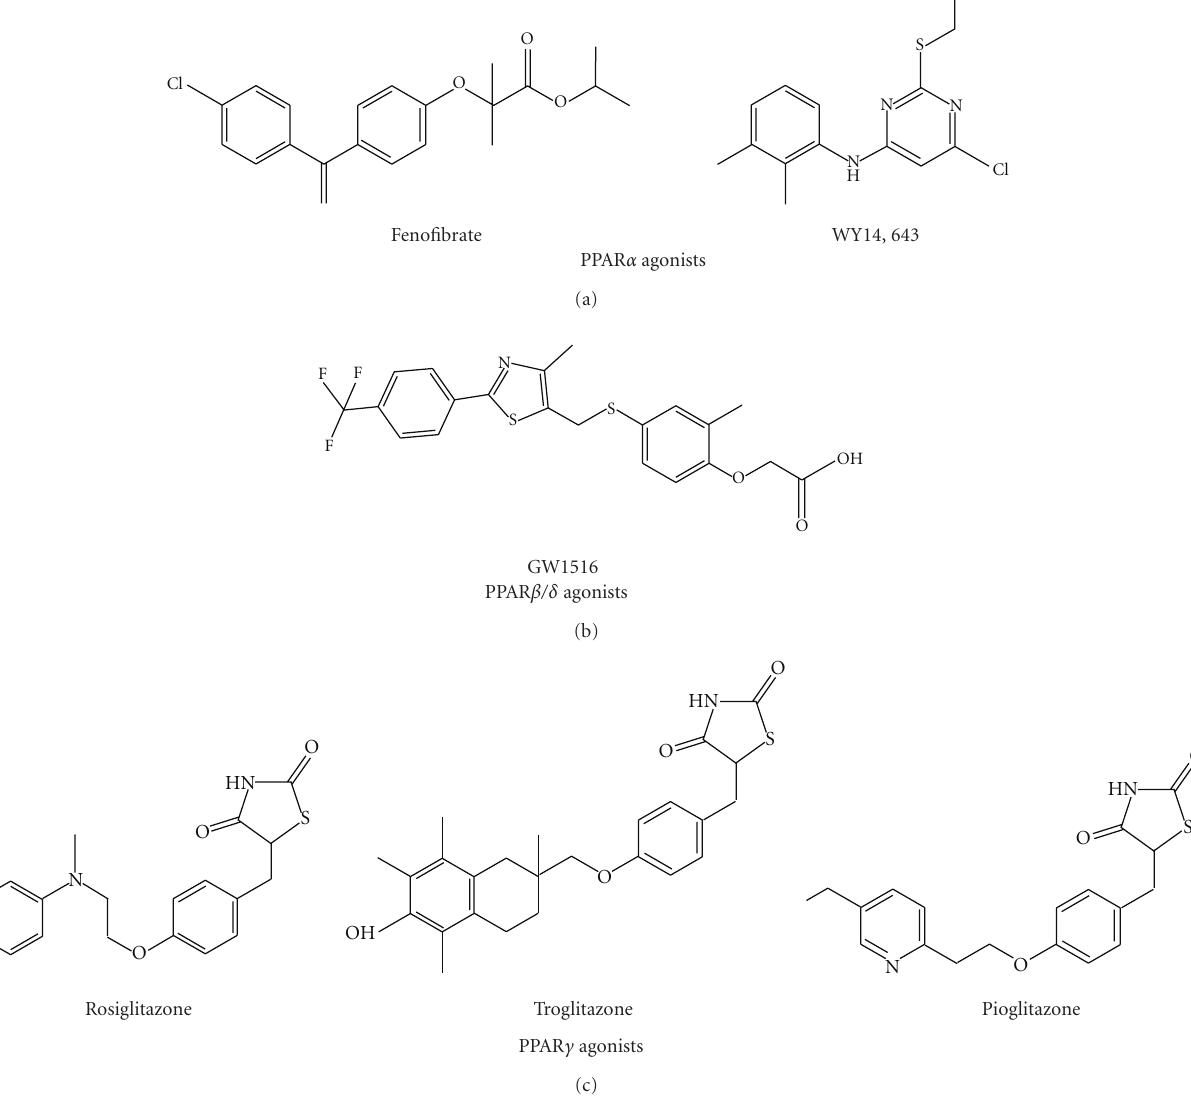
Figure 1: The chemical structures of PPAR